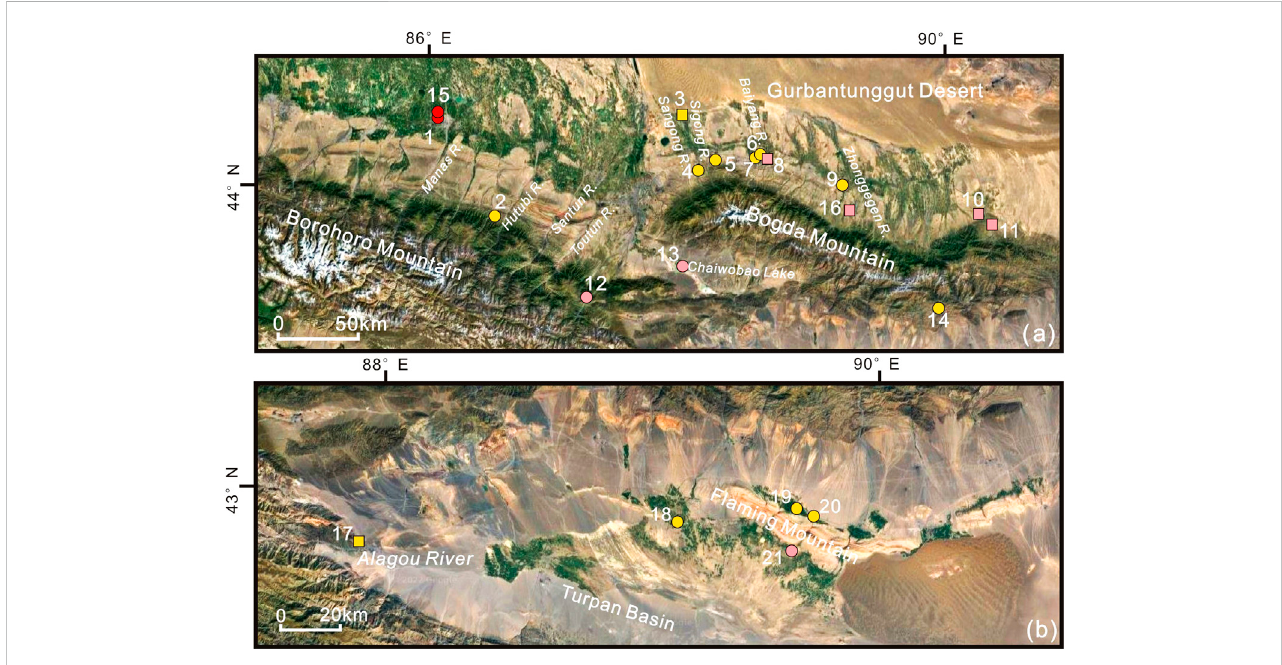
FIGURE 5 Topographic map of middle Tianshan Mountains and the sites mentioned in this study. (A) Areas on both sides of the middle Tianshan Mountains. 1. Liangzhongchangyilian; 2. Shimenzi; 3. Fukangfubeinongchangjijiandui; 4. Sangongxiang; 5. Choumeigou; 6. Xigou Ⅱ area; 7. Baiyanghe; 8. Xigou Ⅰ area; 9. Dalongkou;10.Sidaogou; 11.Gangou; 12.Saensayi; 13.Chaiwobao;14.Ertanggou;15.Shuinichang;16.Luanzagangzi. (B) TurpanBasin.17. Yuergou; 18.Jiayi; 19. Shengjindian; 20. Subeixi; 21.